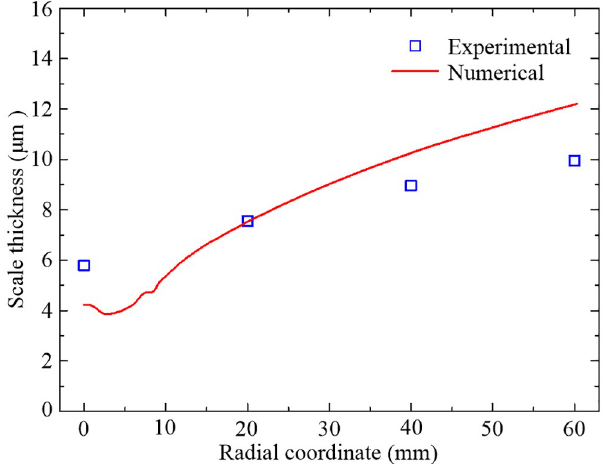
Fig 9. Comparisons of numerical and experimental scale